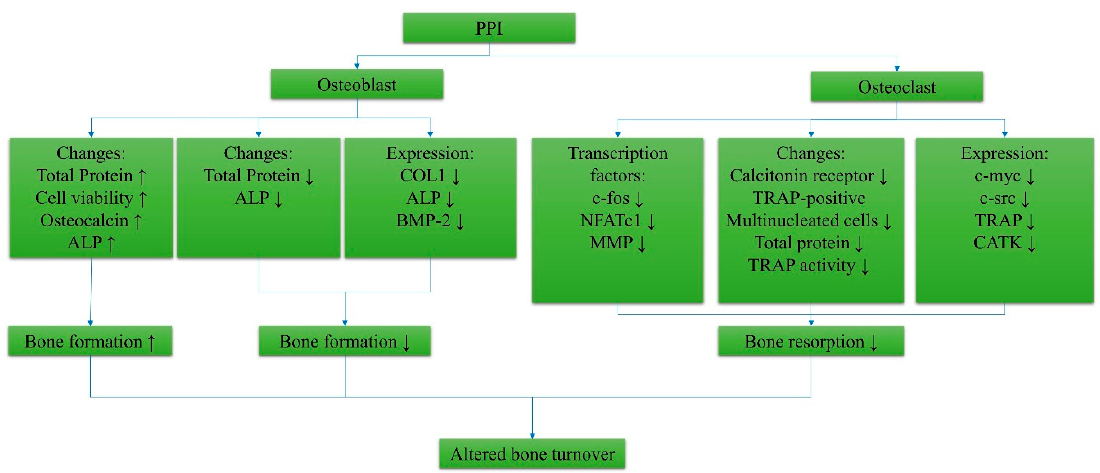
Figure 2. Summary of the cellular effects of proton pump inhibitors on bone cells. Abbreviations: PPI, proton pump inhibitor; ALP, alkaline phosphatase; TRAP, tartrate-resistant acid phosphatase; COL 1, collagen type 1; BMP-2, bone morphogenetic protein-2; NFATc1, nuclear factor of activated T-cells; MMP, matrix metalloproteinase 9; CATK, cathepsin K.